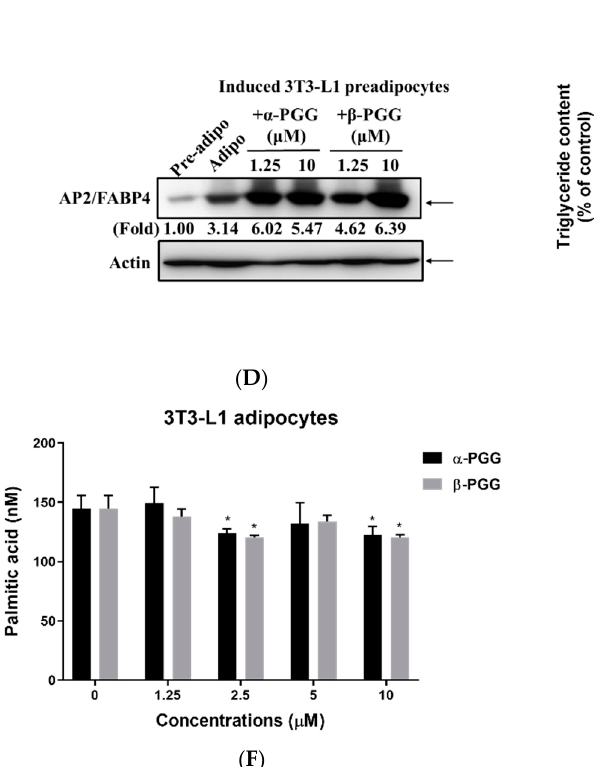
Figure 3. Effect of PGG on the adipogenesis and lipid content of 3T3-L1 cells . During adipogenesis, 3T3-L1 cells were treated with α -or β -PGG. ( A ) Morphology with oil-red O staining, ( B ) quantification of triglyceride content ( n = 6) and ( C ) Pref-1 and perilipin protein expression, as measured at the end of the differentiation process. ( D ) aP2/FABP4 protein expression in pre-adipocytes and during adipogenesis in the presence of PGGs was compared. By using differentiated 3T3-L1 adipocytes, the effect of PGG on ( E ) triglyceride content ( n = 6) and ( F ) free fatty acid levels ( n = 3) were evaluated. Data are shown as mean ± SEM. * p < 0.05 and *** p < 0.001 compared to control (vehicle). ∆∆∆ p < 0.001 compared with corresponding α -PGG group.